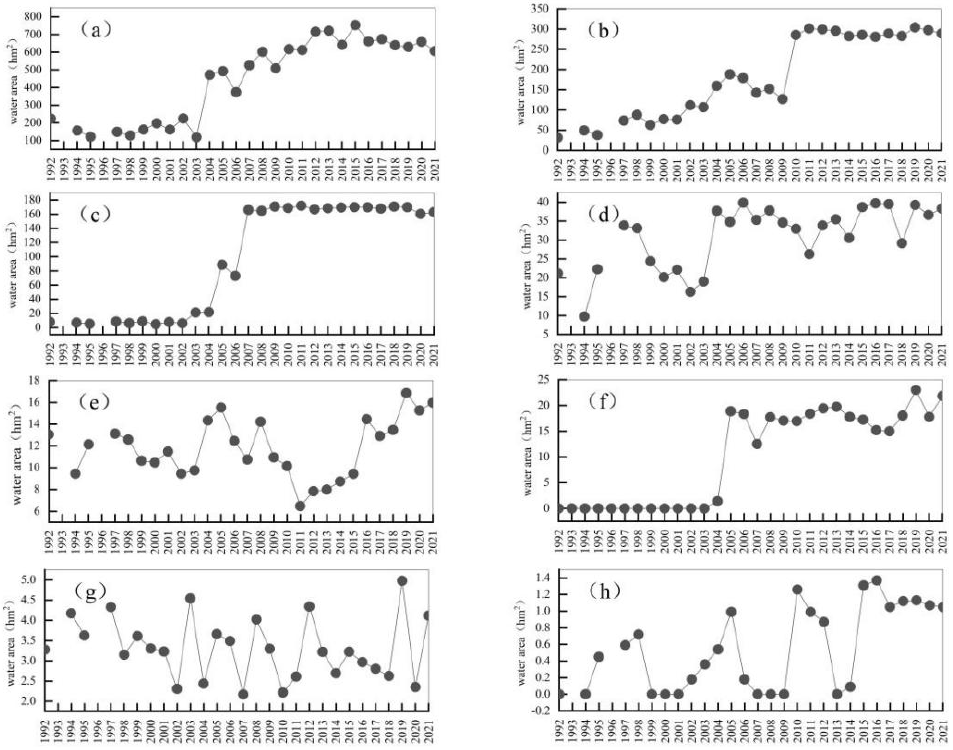
Figure 11. Interannual variation in water body area: ( a ) TWSA, ( b ) Tenggeli Lake, ( c ) Xiaohu Lake, ( d ) Gaodun Lake, ( e ) Machang Lake, ( f ) Qiandao Lake, ( g ) Mengjiawan Reservoir, ( h ) Changliushui Reservoir.